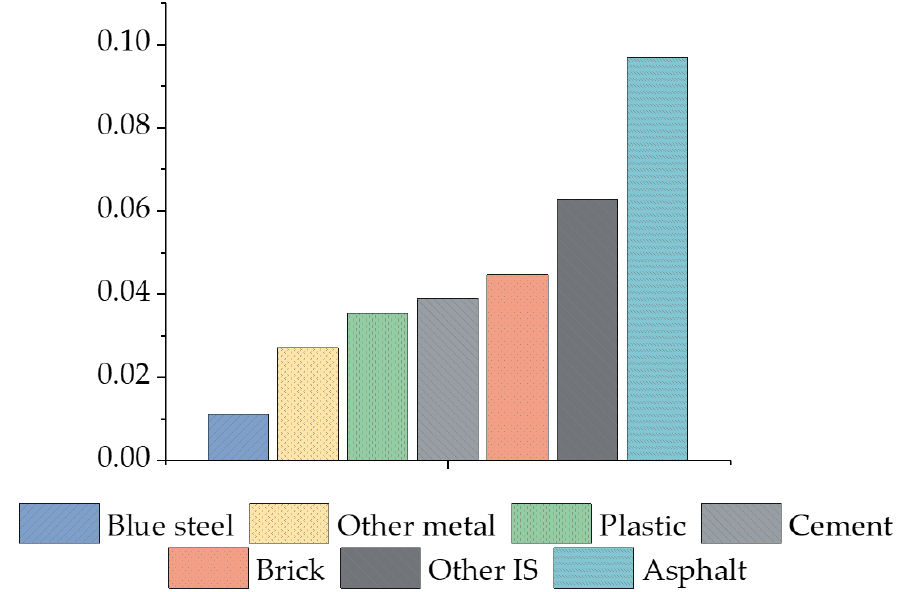
Figure 12. Proportion of ground objects in